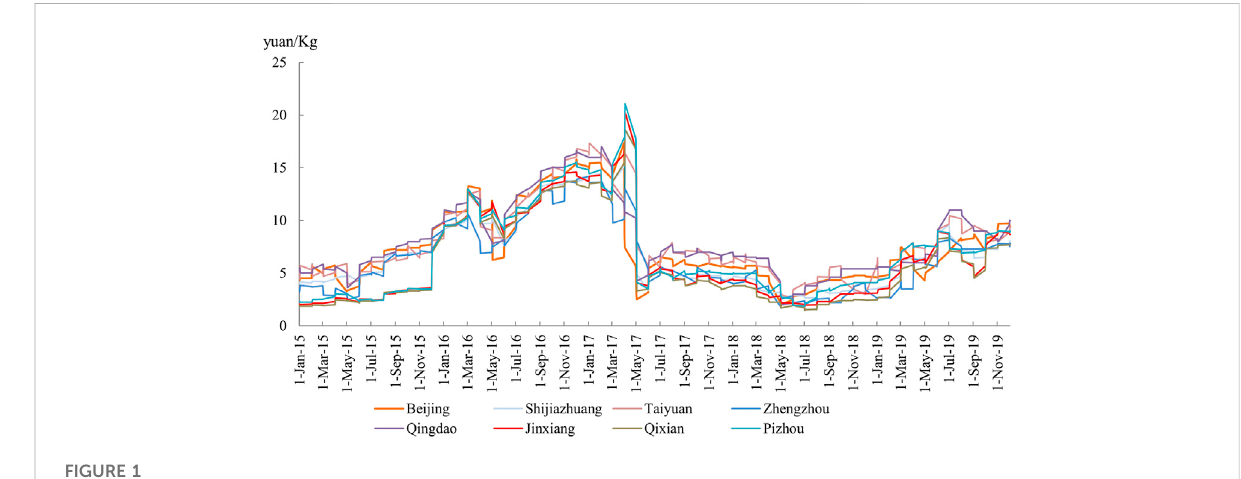
FIGURE 1 Prices of several cities in China from 2015 –